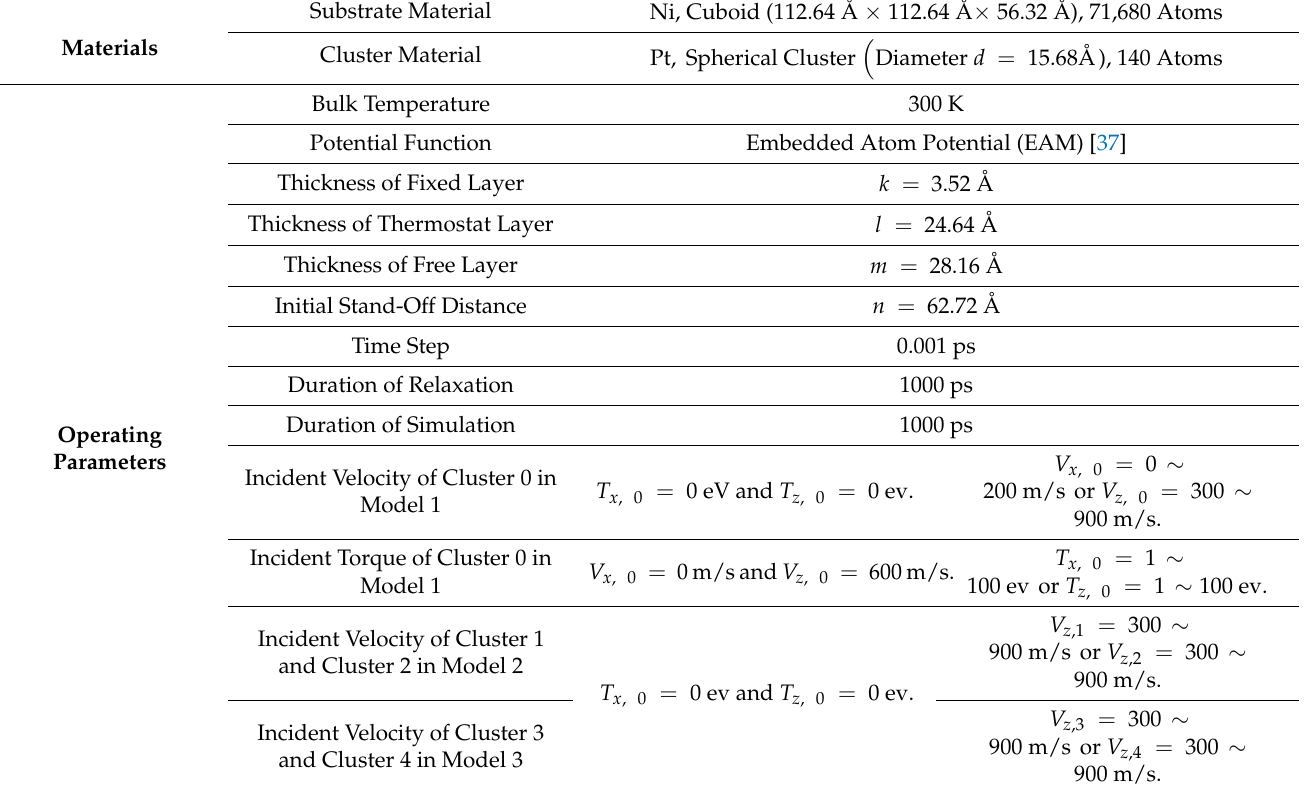
Table 1. Parameters used in the MD simulation of CGDS